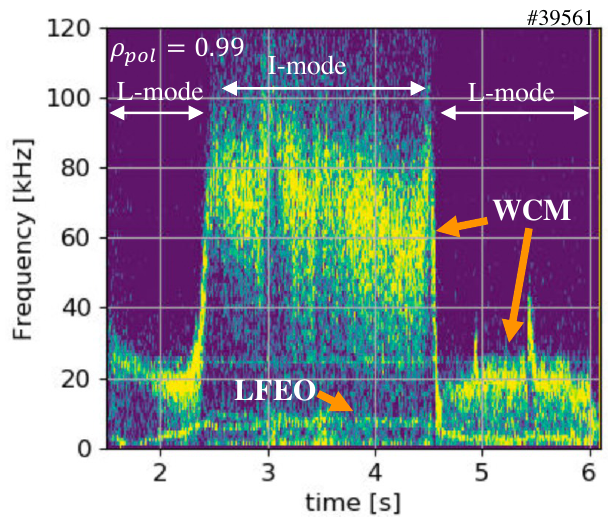
Figure 2. Spectrogram from CECE channel 19 near the WCM peak amplitude of ρ pol = 0 . 99. The discharge develops from L-mode ( < 2.4s) to I-mode (2.4-4.5s) to L-mode ( > 4.5s) and the WCM appears as the 20 kHz mode in L-mode which spins up to the 40-90 kHz in I-mode, and then back to 20 kHz in L-mode. LFEO is the narrowband mode at 8 kHz which appears in the I- mode phase